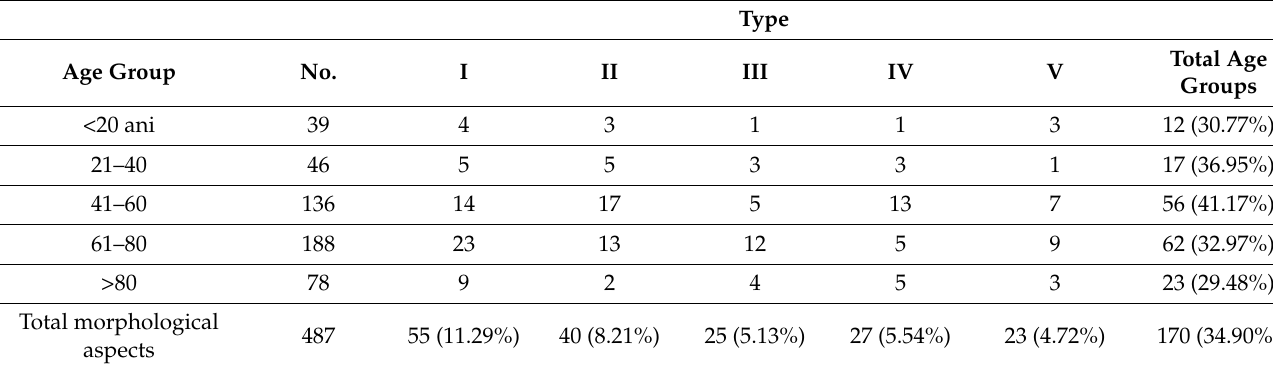
Table 4. Ponticulus posticus—morphology-wise demographic